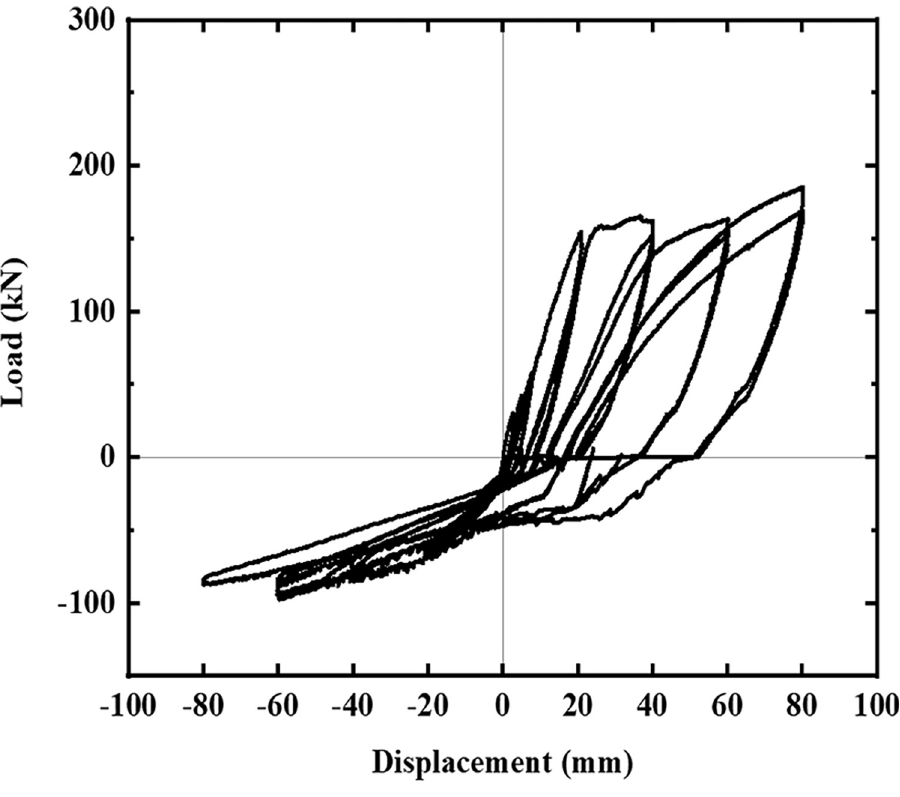
Fig 19. Hysteresis curve of